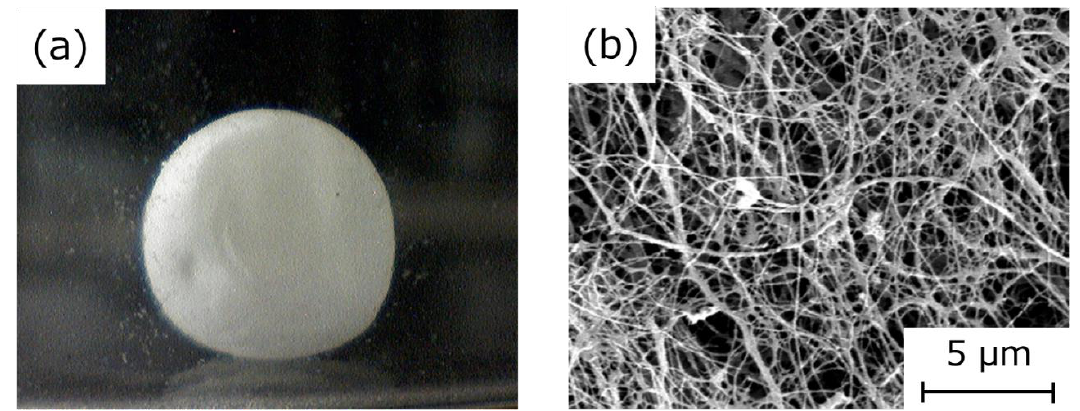
Figure 5. ( a ) Photograph of the HSBC aerogel. ( b ) Scanning electron microscopy (SEM) image of HSBC aerogel.